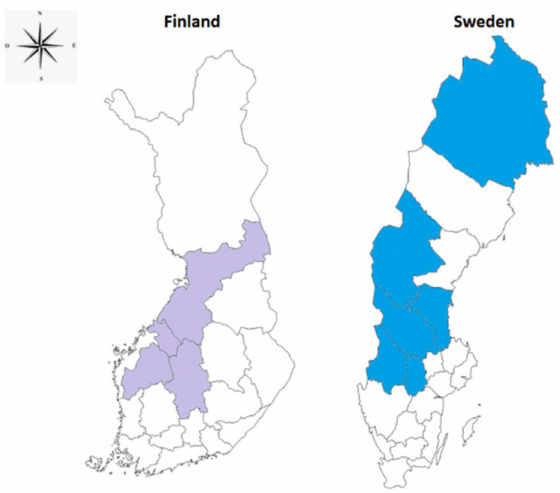
Figure 1. Tularemia high-risk areas in Finland highlighted with purple color and in Sweden high- lighted with blue color